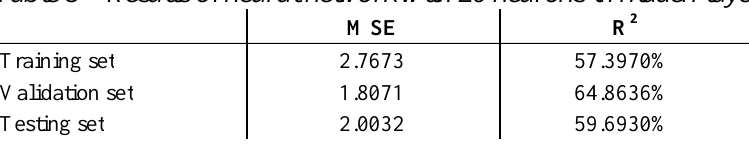
Table 3 – Results of neural network with 20 neurons in hidden